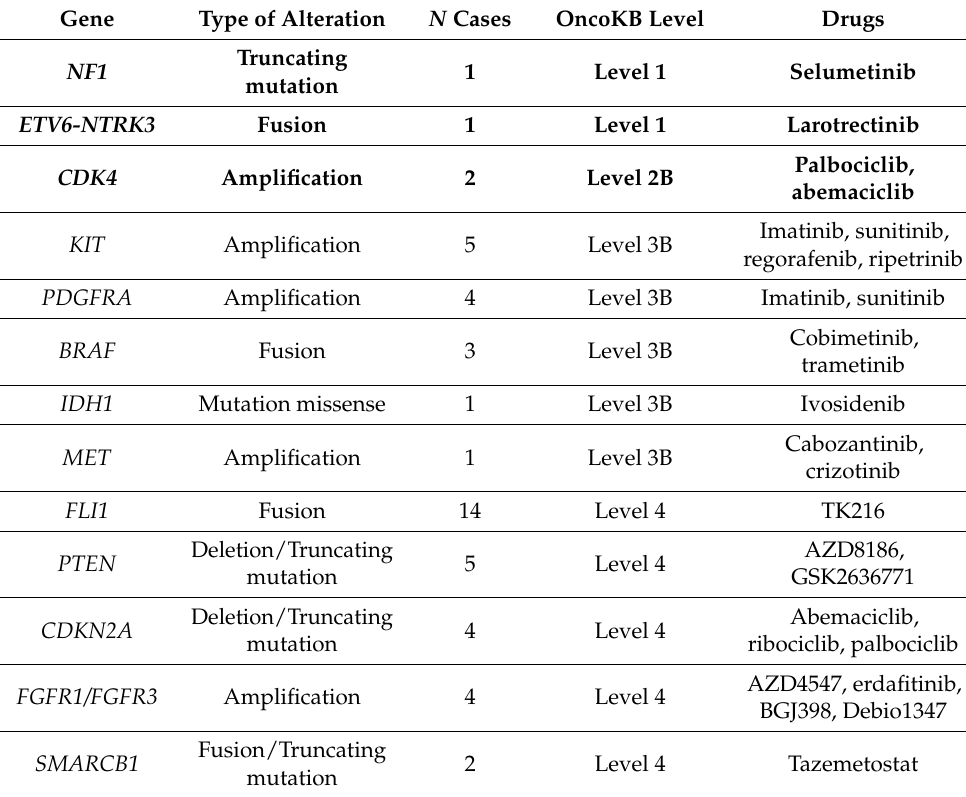
Table 2. Potentially actionable alterations identified by OncoKB in 53